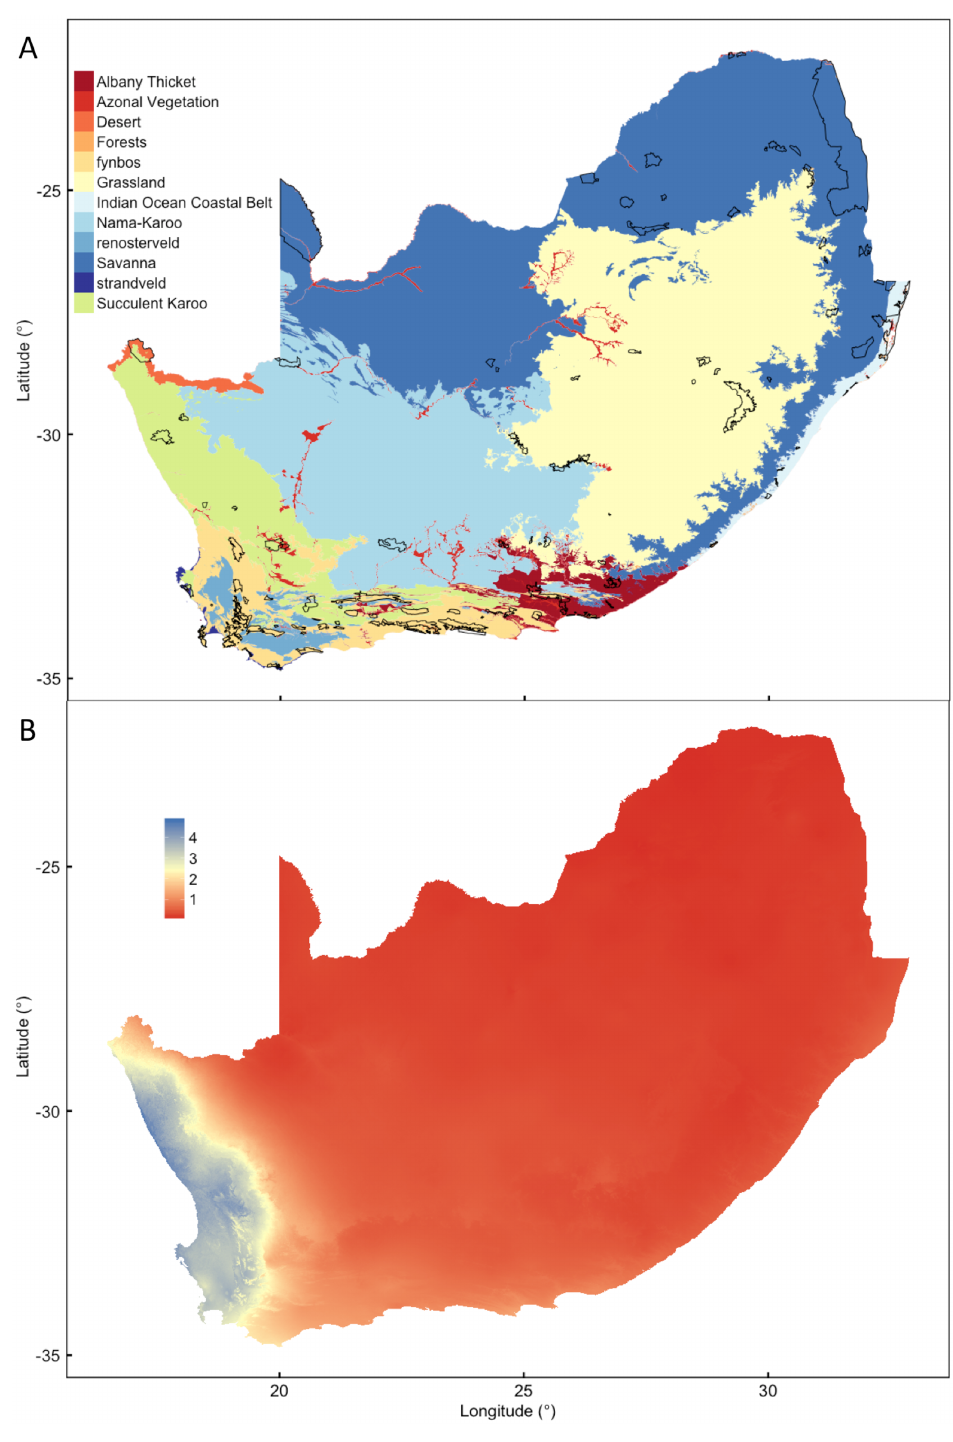
Fig 1. Maps of (A) the biomes of South Africa with the Fynbos biome separated into fynbos, renosterveld and strandveld, and (B) the ratio of winter half-year (Apr – Sep) to summer half-year precipitation. The conservation areas that were sampled using a 1 km 2 grid of points are